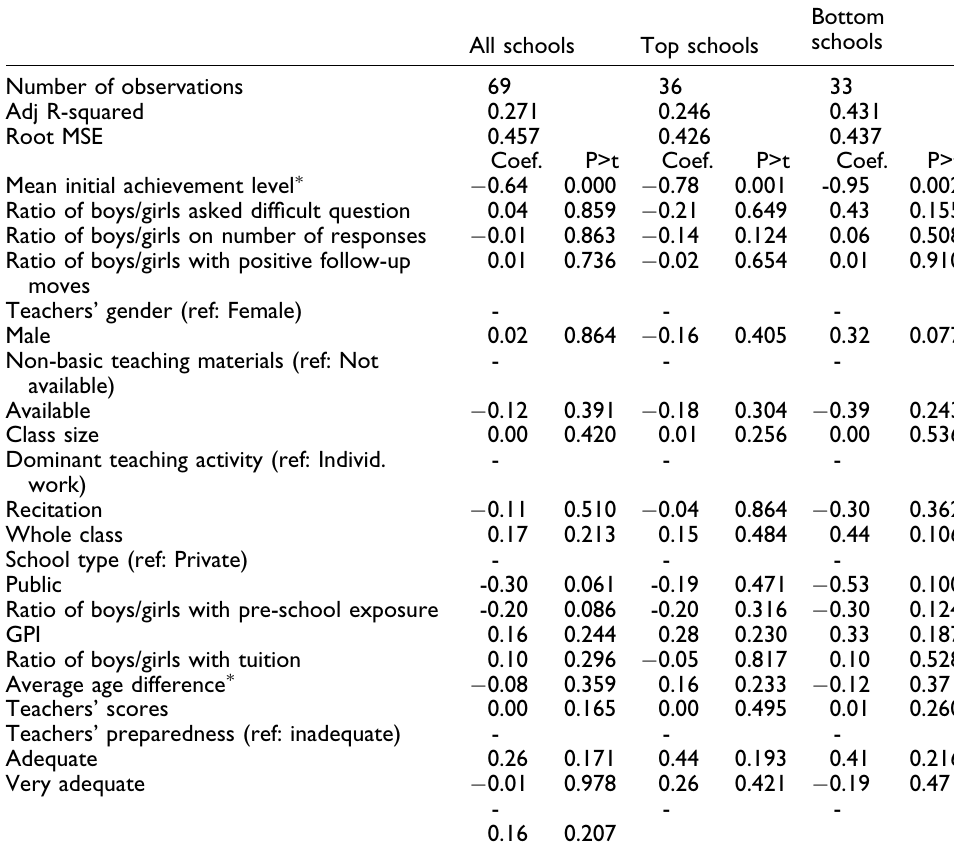
Table 7. Regression analysis results based on performance in measurement test